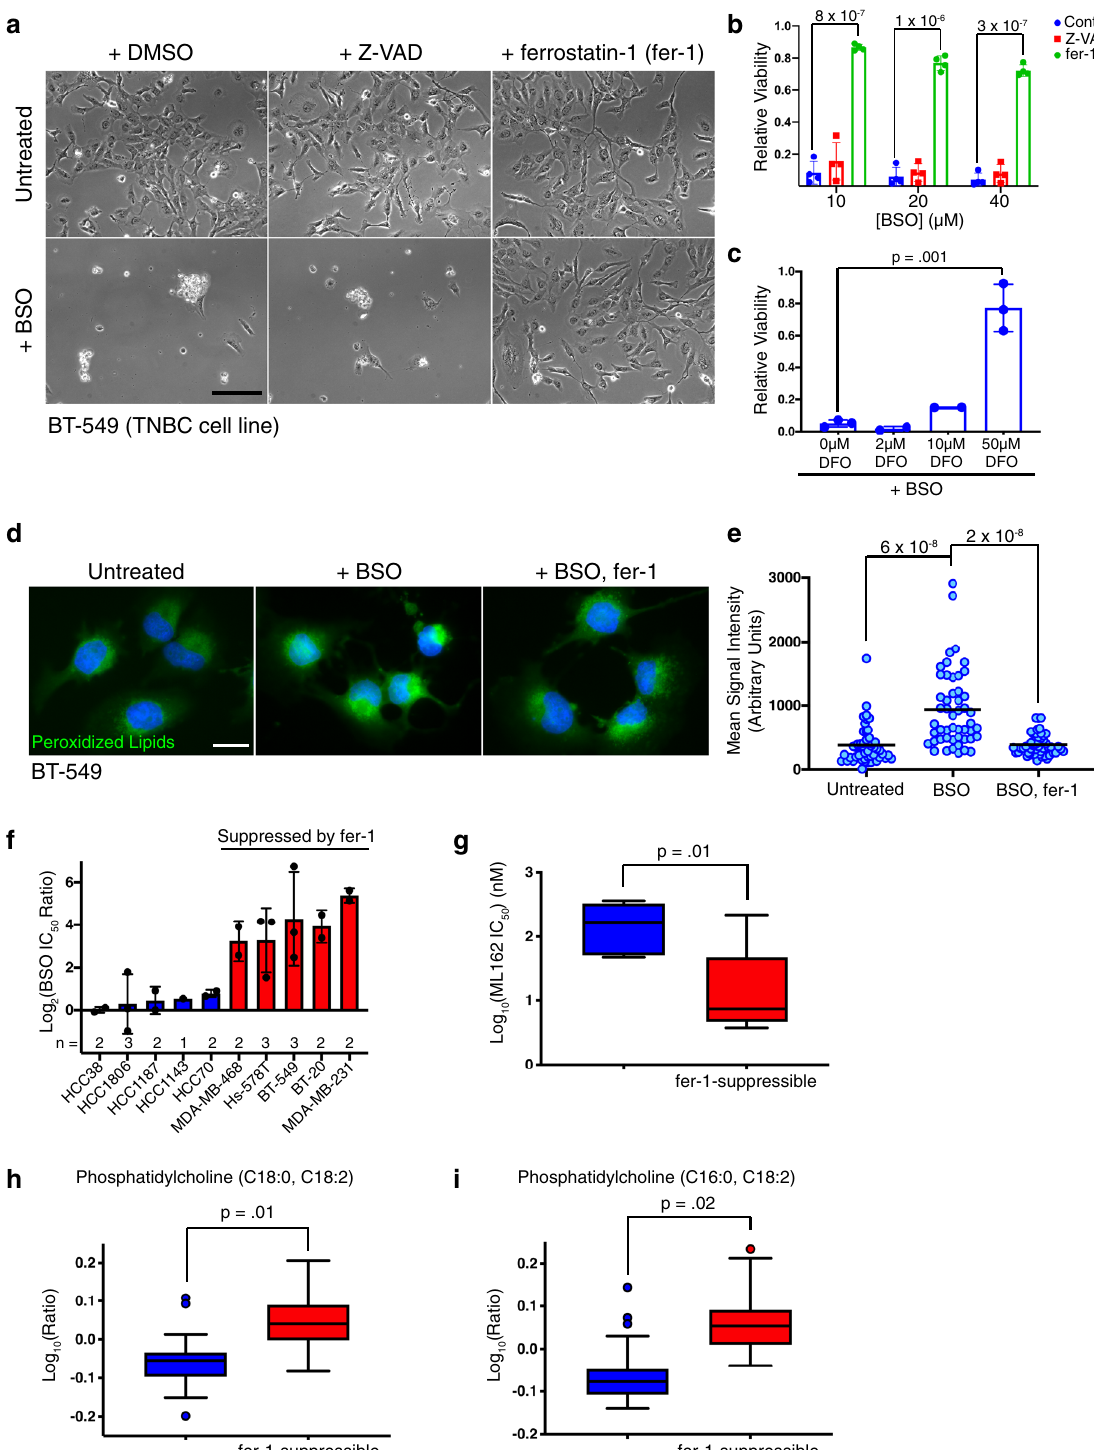
α ESA is incorporated into diverse cellular lipids . To examine how α ESA is metabolized, we conducted a lipidomic analysis of MDA-MB-231 cells treated with α ESA for three hours, prior to overt cell death. Lipids containing acyl chains with 18 carbons and three double bonds (18:3), consistent with α ESA, were rare in untreated cells (Fig. 2g, blue bars), but were found in diverse lipids in α ESA-treated cells, including phospholipids and neutral lipids (green bars; Supplementary Data 1). Fer-1 co-treatment did